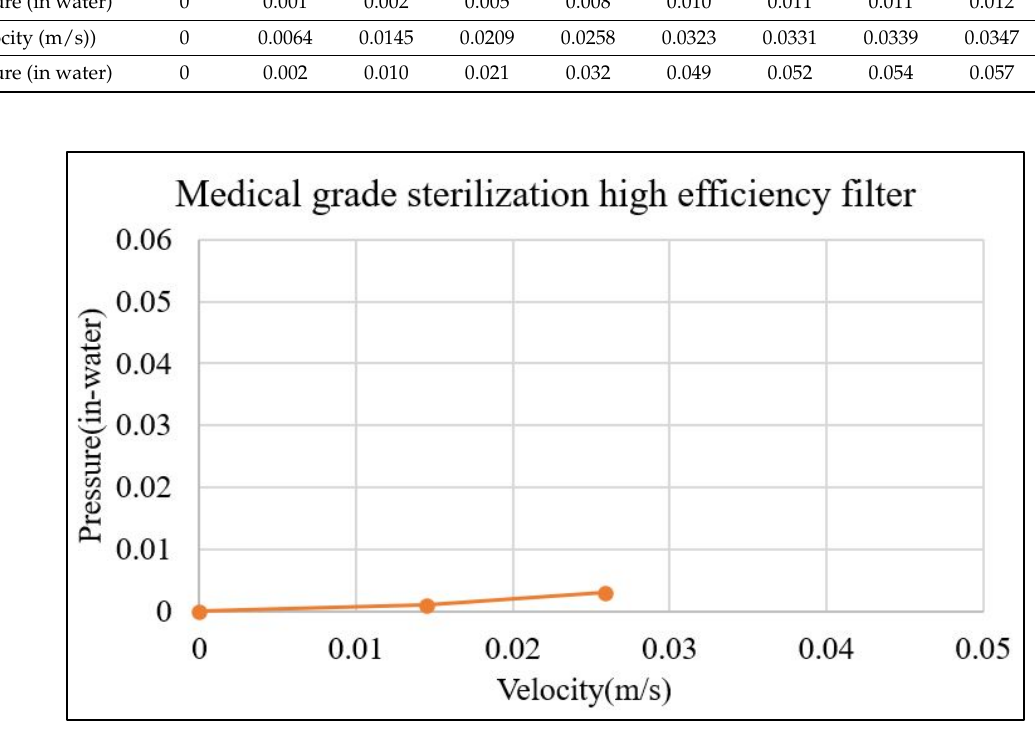
Figure 16. P-Q curve of the high-efficiency medical sterilization filter screen.